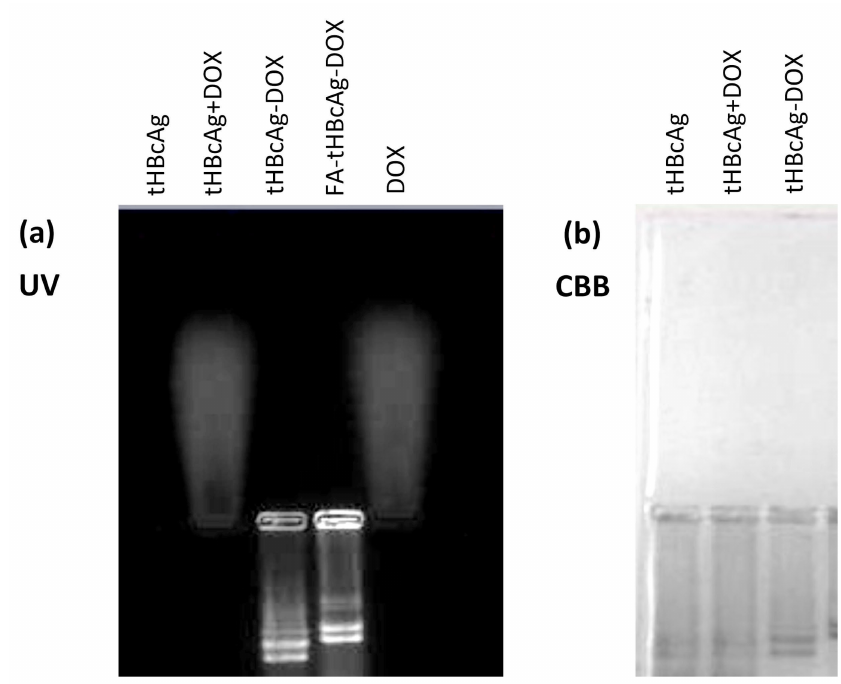
Figure 6. Migration profile of the tHBcAg VLNPs conjugated with folic acid and doxorubicin in a native agarose gel. The same gel was ( a ) visualised under ultraviolet (UV) illumination and ( b ) stained with Coomassie brilliant blue (CBB). Samples labelled on top of the gel images are tHBcAg VLNPs (tHBcAg), tHBcAg VLNPs incubated with doxorubicin (DOX) without the conjugation steps (tHBcAg + DOX), tHBcAg VLNPs conjugated with DOX (tHBcAg-DOX), tHBcAg VLNPs conjugated with folic acid (FA) and DOX (FA-tHBcAg-DOX), and free